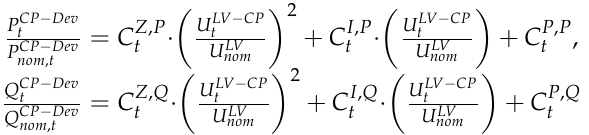
Figure 5. Load and production profiles of different model components of the rural residential CP_Link-Grid: ( a ) Dev.- model; ( b ) Pr.-model; ( c ) St.-model.